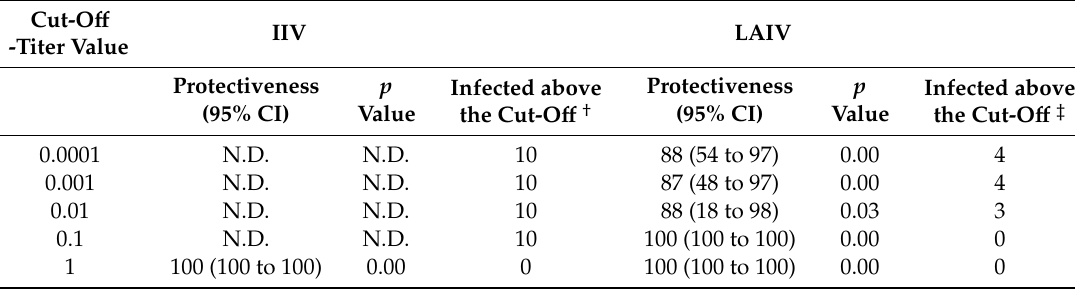
Table 6. Protectiveness of mucosal IgA against